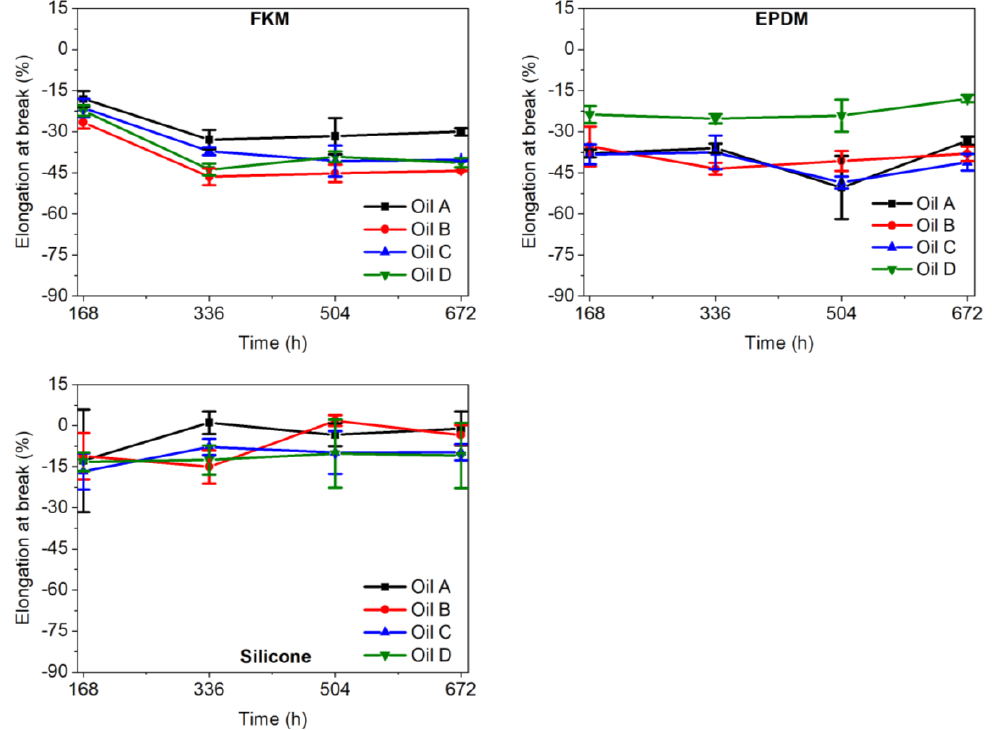
Figure 4. Changes in elongation at break (expressed as the ratio of the elongation at break variation to the initial elongation at break) of FKM, silicone, and EPDM, after aging in oils A, B, C, and